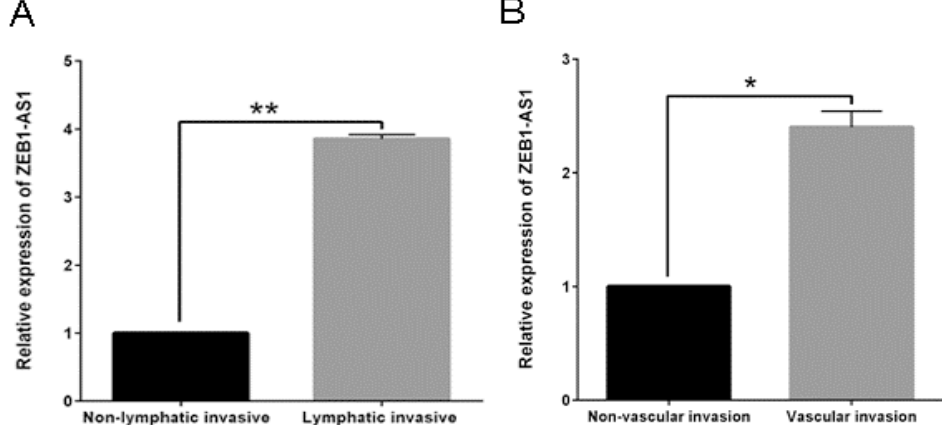
Fig. 3. Relative ZEB1-AS1 expression with metastatic lymph nodes tumors: (A) The expression of ZEB1-AS1 was significantly higher in metastatic lymph nodes tumors rather than non-lymph node metastases tumor tissues; (B) ZEB1-AS1 expression was upregulated in vascular metastatic tumor tissues in comparison to non-vascular invasive tumor specimens. Data are shown as mean±SD (*p < 0.05; **p <